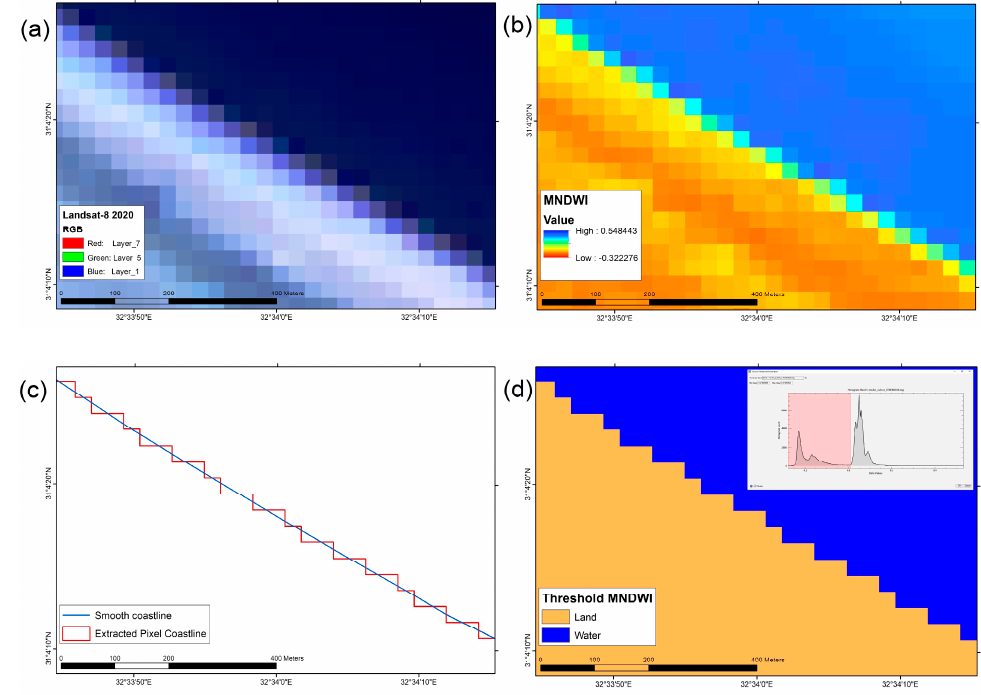
Figure 5. Coastline auto-extraction. ( a ) Landsat-8 taken in 2020; ( b ) MNDWI values; ( c ) vector-based pixel and smooth extraction for coast; and ( d ) binary land/water